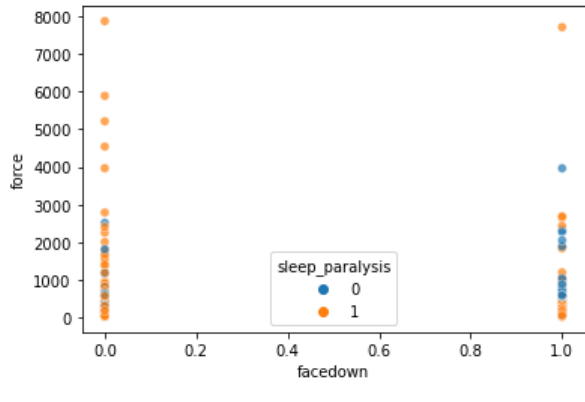
Figure 14. Face Down vs Sleep paralysis